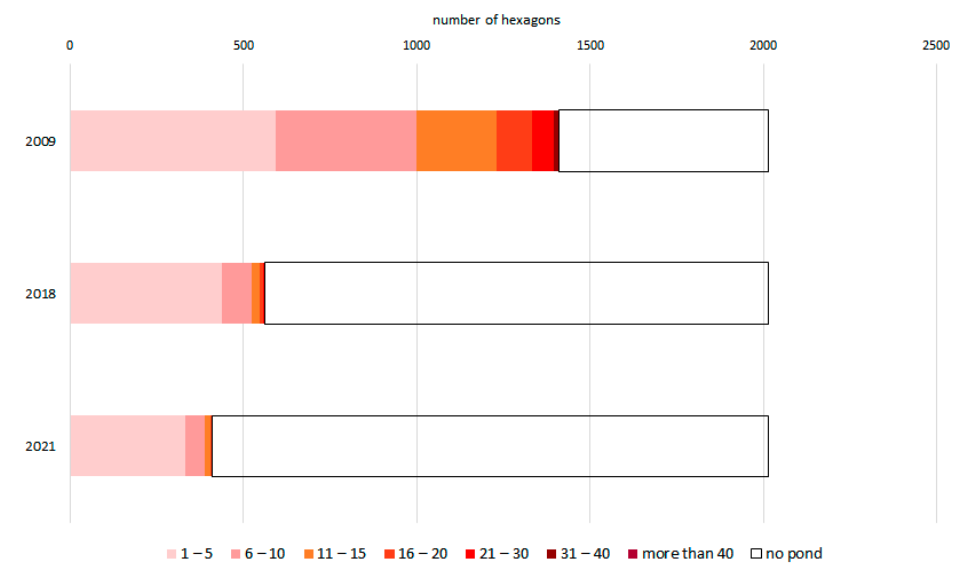
Figure 8. Graph of the number of ponds per hectare for the years 2009, 2018, and 2021.